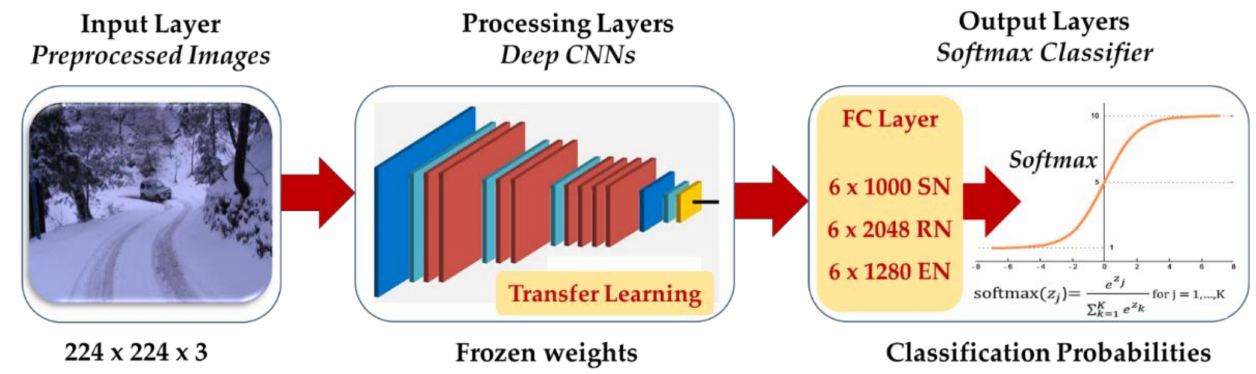
Figure 6. Development stages of the learning model